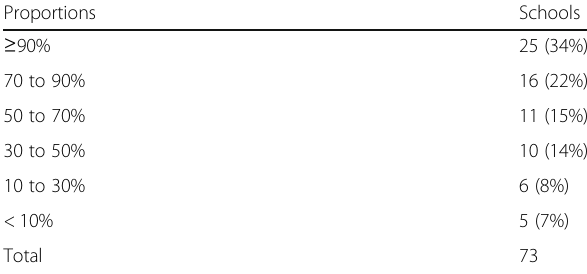
Table 1 Percentages of graduates becoming clinical pharmacists after graduating from Japanese pharmacy schools Proportions